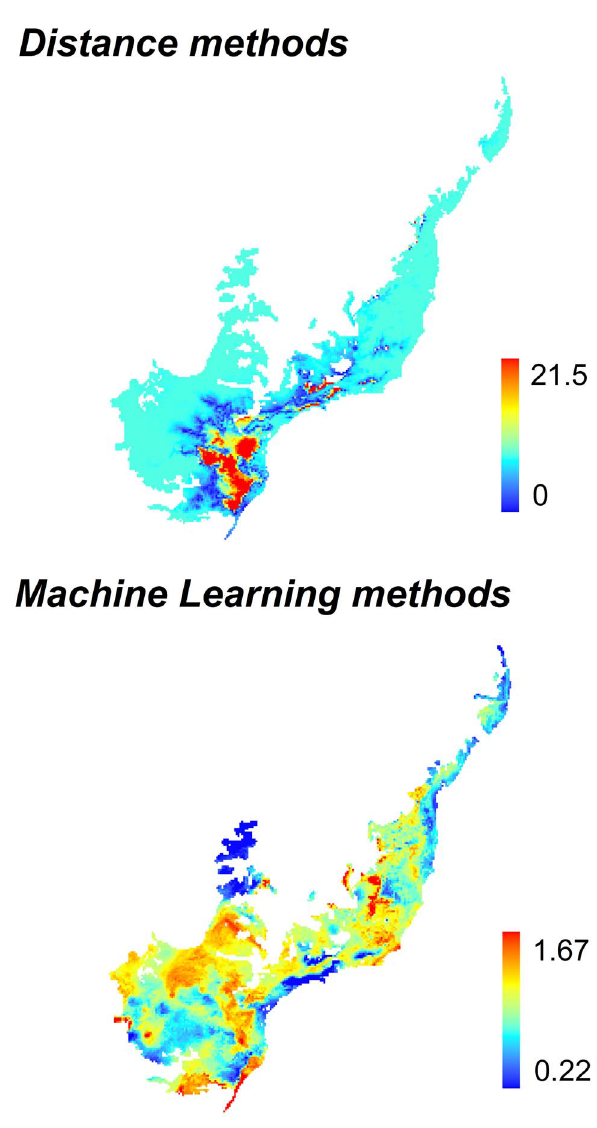
Figure 4. Species turnover pattern for tiger moths in the Atlantic Forest Biodiversity Hotspot, Brazil. Maps of modeled tiger moth species turnover based on consensus projections of 507 species predicted to occur in the Atlantic Forest Biodiversity Hotspot, Brazil, for current time (1950–2000) and 2080 (2051–2080) according to two different types of modeling methods and climate models. Models from distance and machine-learning methods were combined through an ensemble of forecasts to generate these consensus